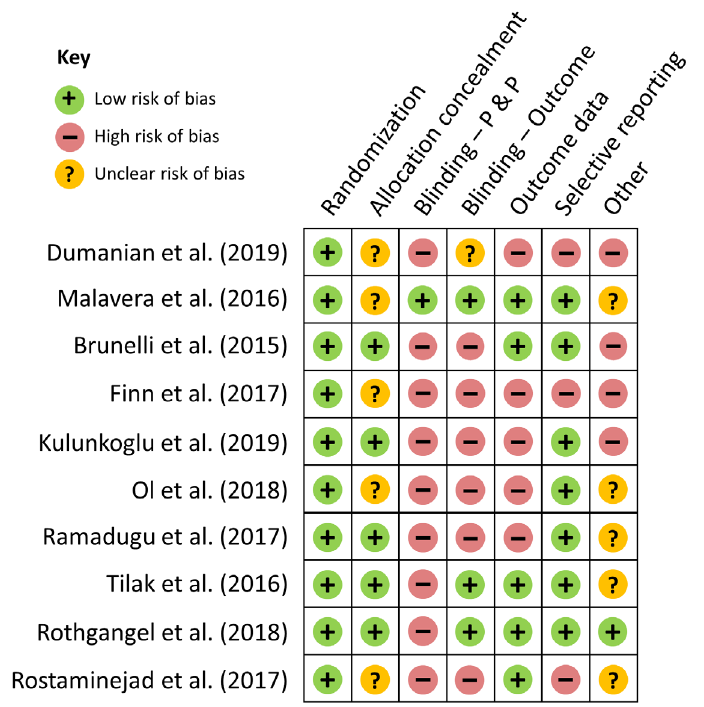
Figure 1. Risk-of-bias 8 assessments for studies presented in the review of recent randomized controlled trials exploring treatment of phantom limb pain. Randomization: randomization sequence generation; Blinding – P & P: blinding of participants and personnel; Blinding – Outcome: blinding of outcome assessment; Outcome data: incomplete outcome